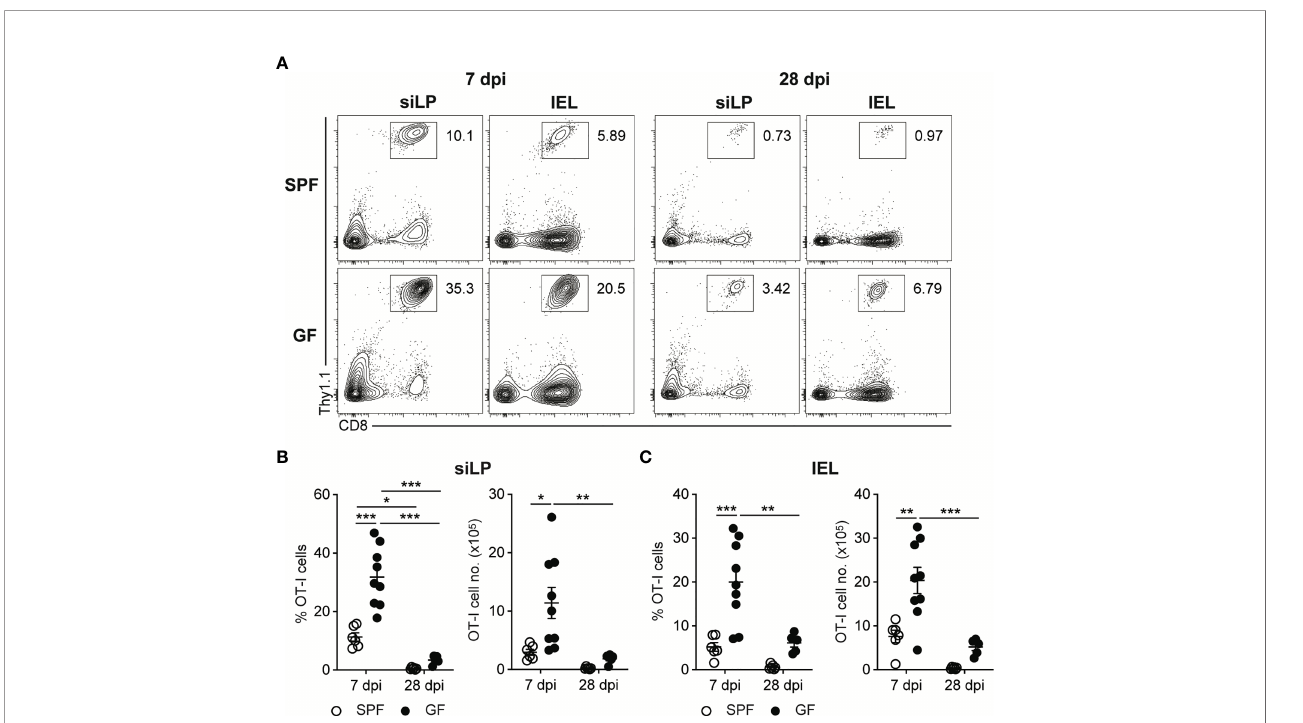
FIGURE 2 | Oral L. monocytogenes Infection Generates Acute CD8 + T cells Response in GF mice as well as in SPF mice. 5 x 10 5 OT-I cells were adoptively transferred into SPF and GF mice. Next day, mice were orally infected with InlA m LM-OVA . Recovery of donor OT-I cells from small intestinal intraepithelial lymphocytes (IEL) and small intestinal lamina propria (siLP) was determined at 7 and 28 dpi. (A) Representative FACS plots showing the percentage of donor OT-I cells gated on lymphocytes. Percentage of donor OT-I cells (left) and total number of donor OT-I cells (right) in siLP (B) and IEL (C) at 7 and 28 dpi. Data point represents an individual mouse. Data are pooled from two independent experiments (n=6 for SPF 7 dpi, n=9 for SPF 28 dpi, n=9 for GF 7 dpi, n=5 for GF 28 dpi). Statistical differences were determined by two-way ANOVA with Tukey ’ s multiple comparisons. *P < 0.05, **P < 0.01,